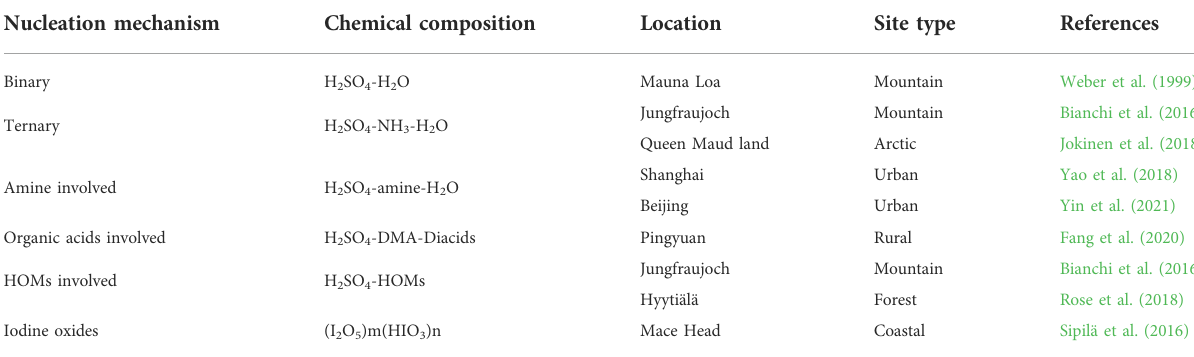
TABLE 1 Summary of nucleation mechanisms in fi eld measurement.